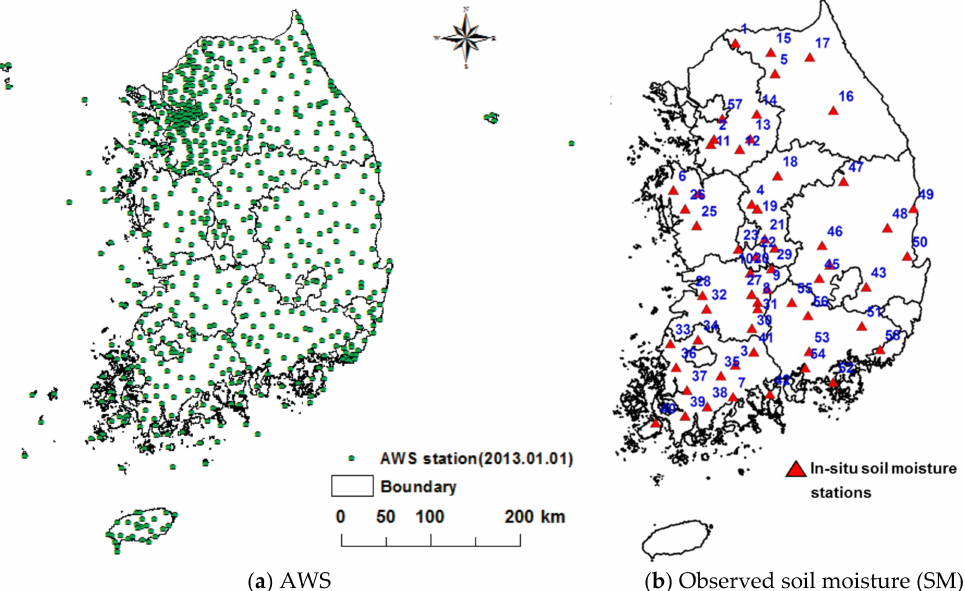
Figure 2. Distributions of observation stations: ( a ) the 687 automatic weather system (AWS) stations for continuous monitoring throughout South Korea and ( b ) the 58 soil moisture stations used for calibration of the multiple linear regression (MLR)